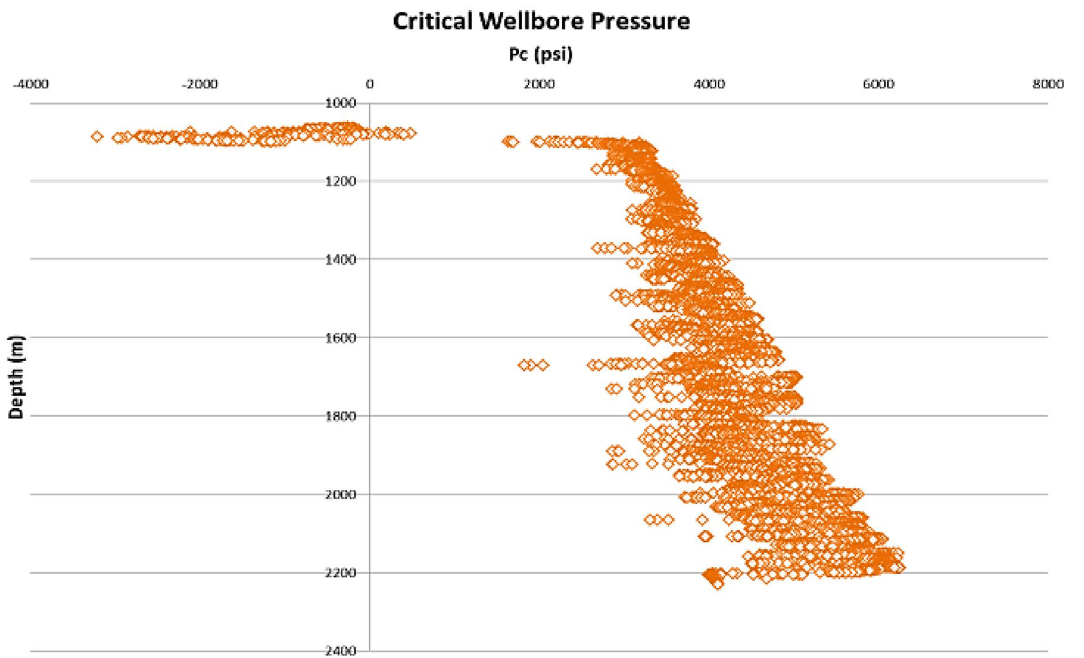
Fig. 2 Critical wellbore pressure along depth of